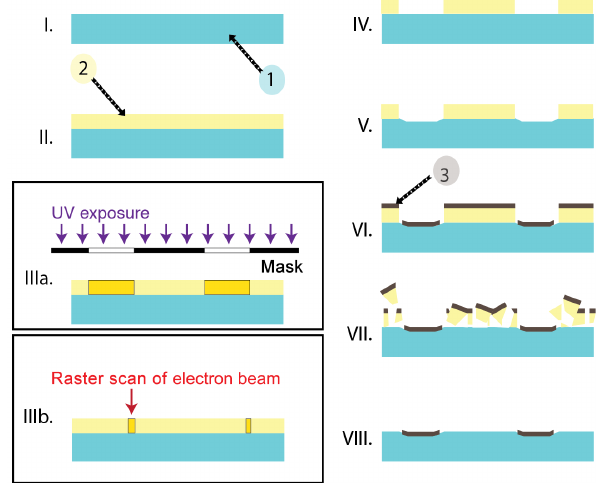
Figure 1. Lithographic process: (1) rock, (2) photoresist or PMMA, and (3) metal layer (sputtered or evaporated). Each step is described in more detail in the text: (I) sample preparation, (II) coating with a polymer (photoresist for photolithography, PMMA for e-beam lithography), (III) exposure to UV rays for photolithography (IIIa) or an electron beam for e-beam lithography (IIIb), (IV) development of the coating, (V) etching, (VI) metal deposition, (VII) dissolution of the remaining polymer, and (VIII) patterned